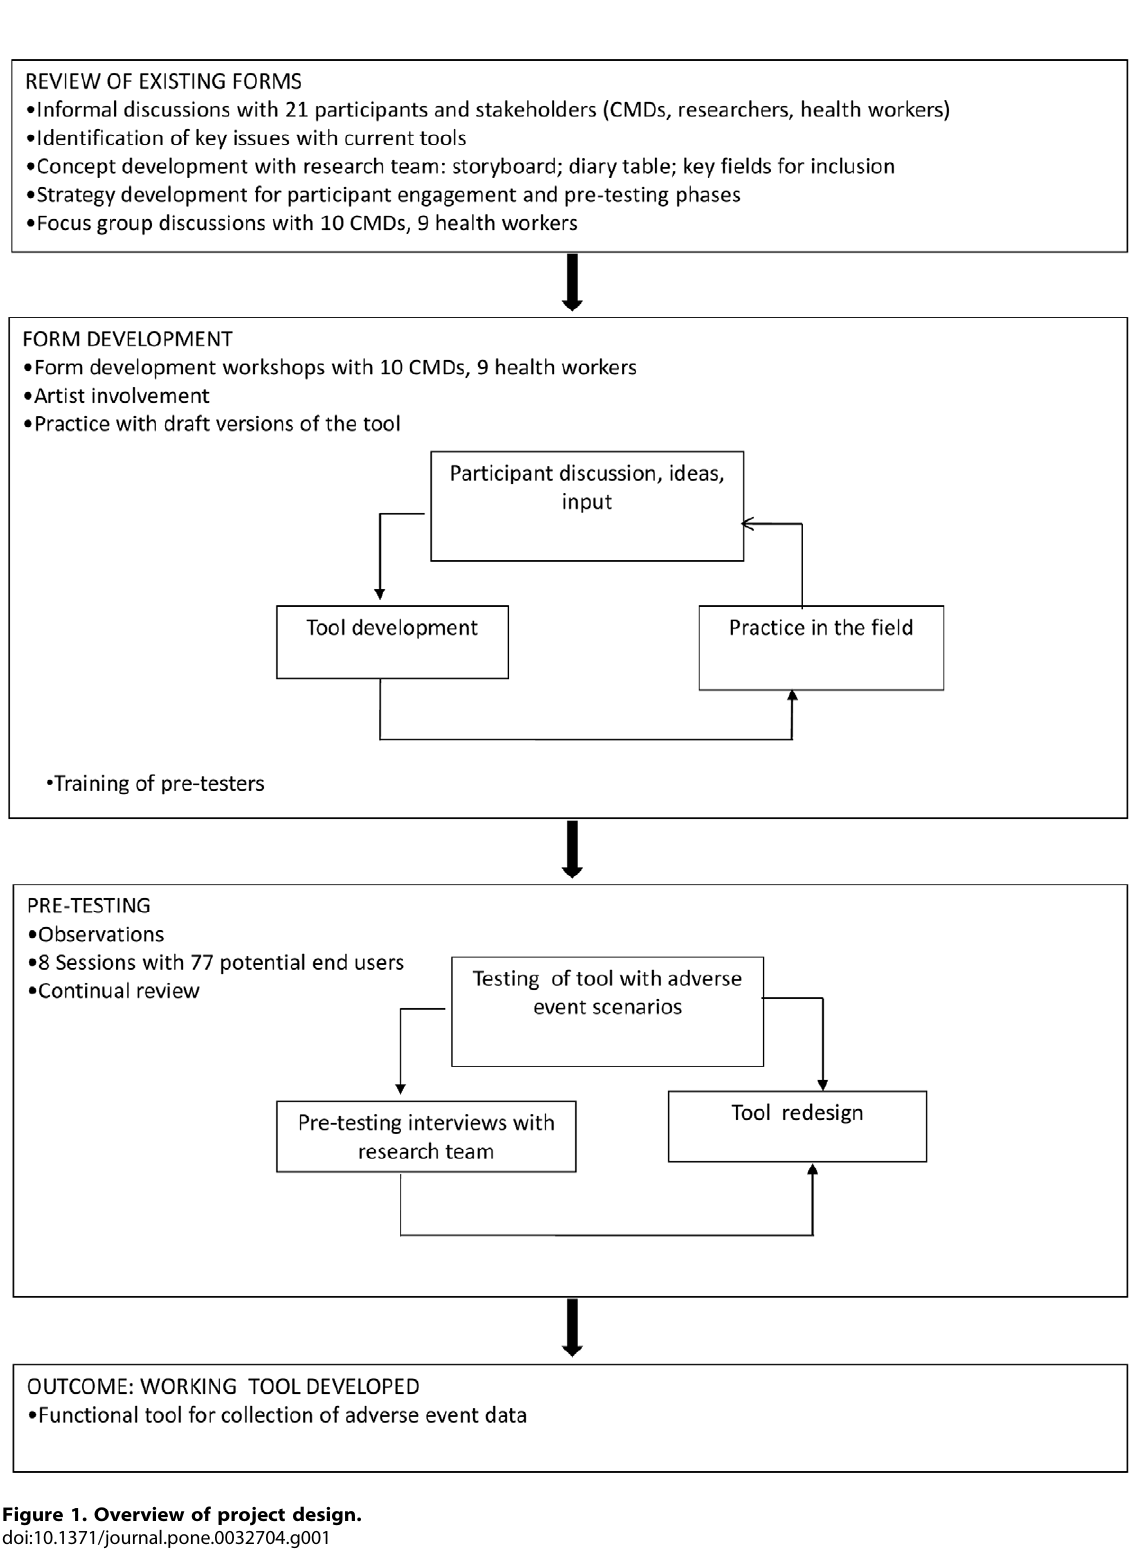
Figure 1. Overview of project design.